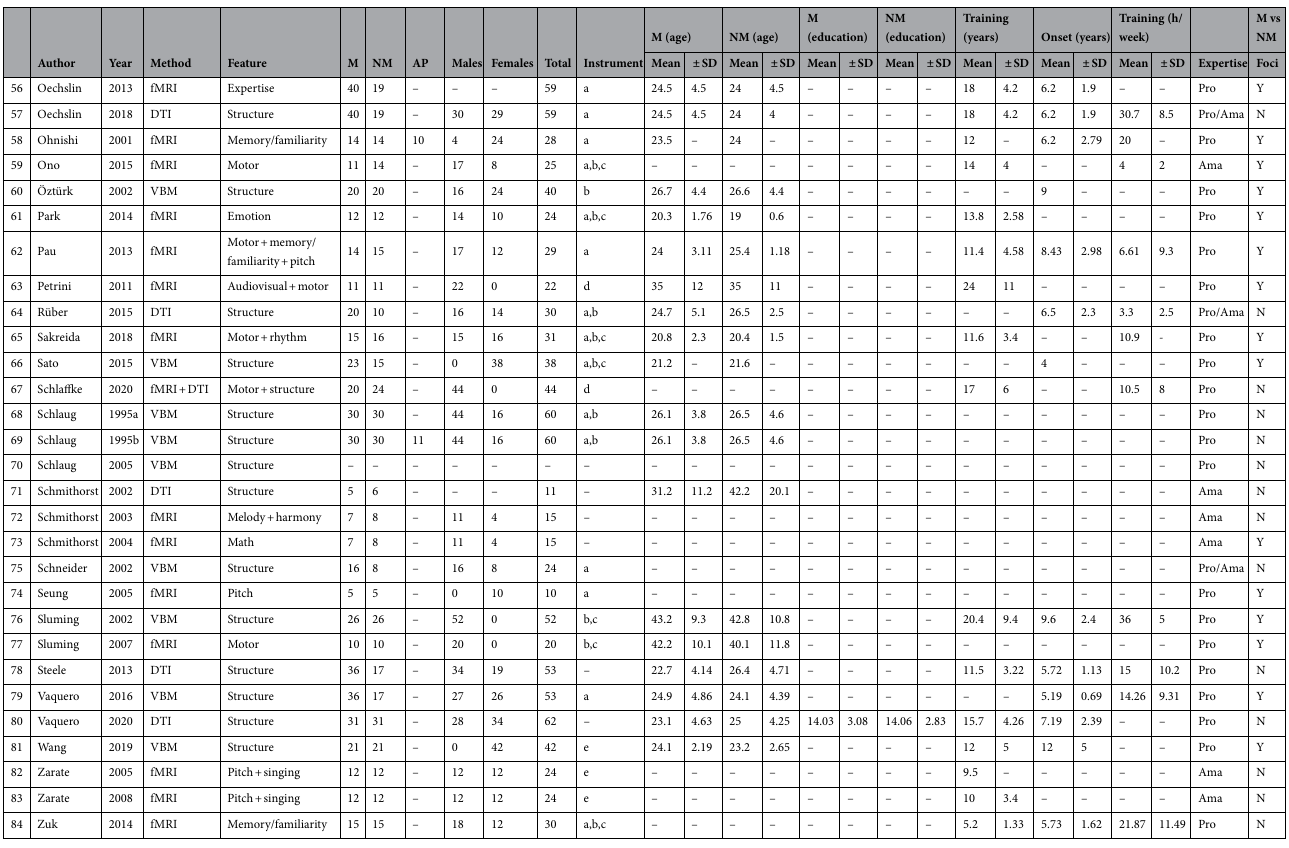
Table 1. Characteristics of studies included in qualitative synthesis. M musicians, NM non-musicians, CT cortical thickness, DBM deformation-based morphometry, DTI diffusion tensor imaging, fMRI